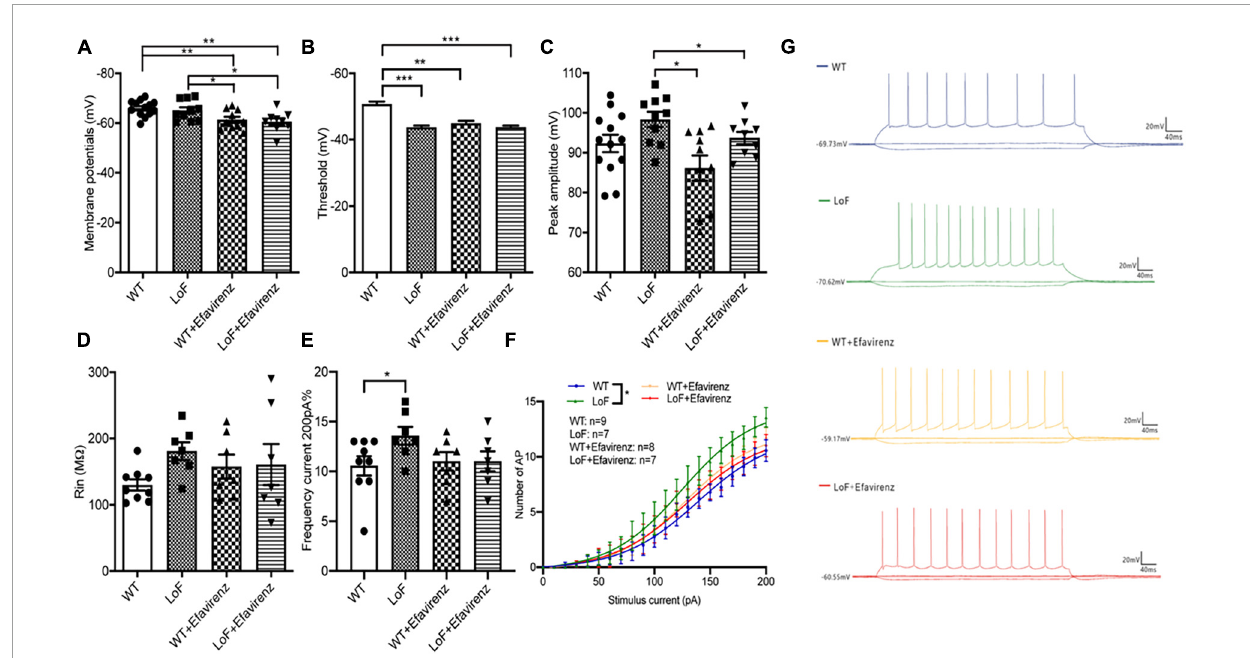
FIGURE5 Comparison of action potential parameters of pyramidal neurons in hippocampal CA1 region of mice. Mouse brain slices were used for recording the action potential of pyramidal neurons in the hippocampal CA1 region. (A) Membrane potential, (B) threshold, (C) peak amplitude, (D) Rin, (E) the number of action potentials at 200 pA current generated by pyramidal neurons, (F) the number of action potential, and (G) representative recordings of AP in each group. * P < 0.05; ** P < 0.01; *** P <